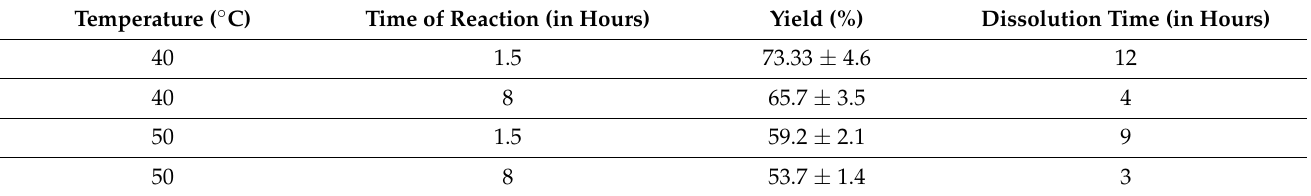
Table 1. Influence of sulfonation temperature and the time of reaction yield and the solubility of SPEEK samples.